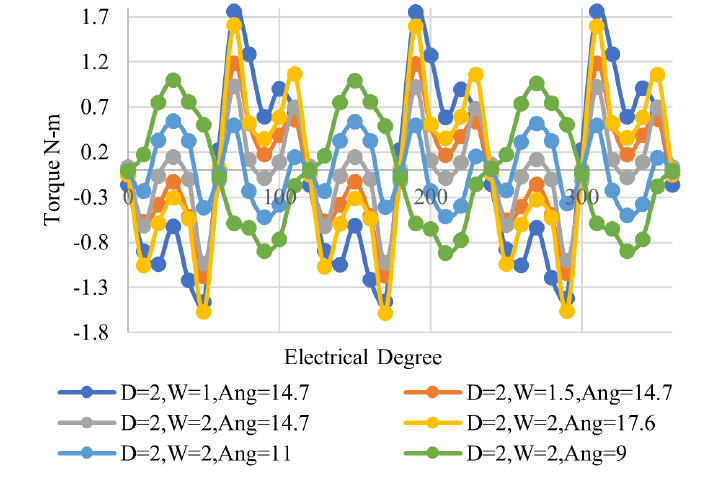
Figure 23. Results of hybrid (notch and arc).